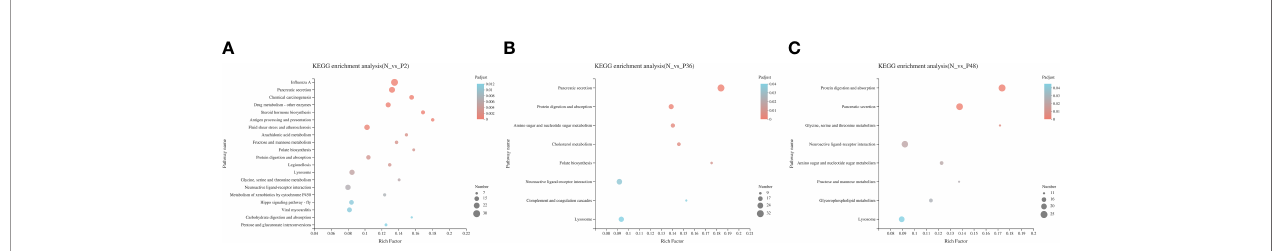
( Figure 5A ). The PLS-DA model evaluation parameters R 2 X (cum) = 0.376, R 2 Y (cum) = 0.518, Q 2 = 0.16 indicated that the